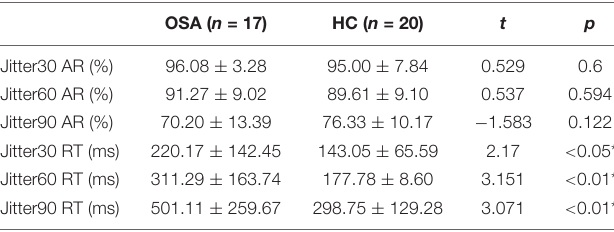
TABLE 2 | Comparison of behavioral results between obstructive sleep apnea (OSA) group and healthy control group ( M ± SD